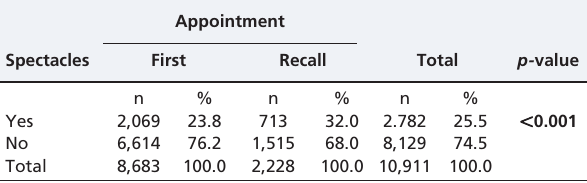
Table 4 - Percentage of spectacles prescribed at each appointment – Guarulhos